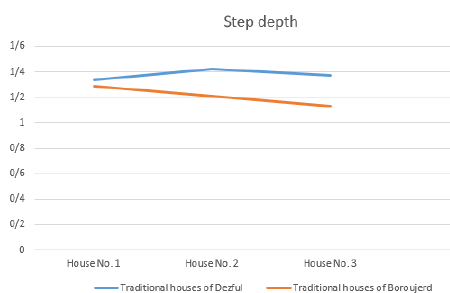
Figure 4. Measuring the depth variable in traditional houses in Dezful and Boroujerd (source: compiled by the authors)